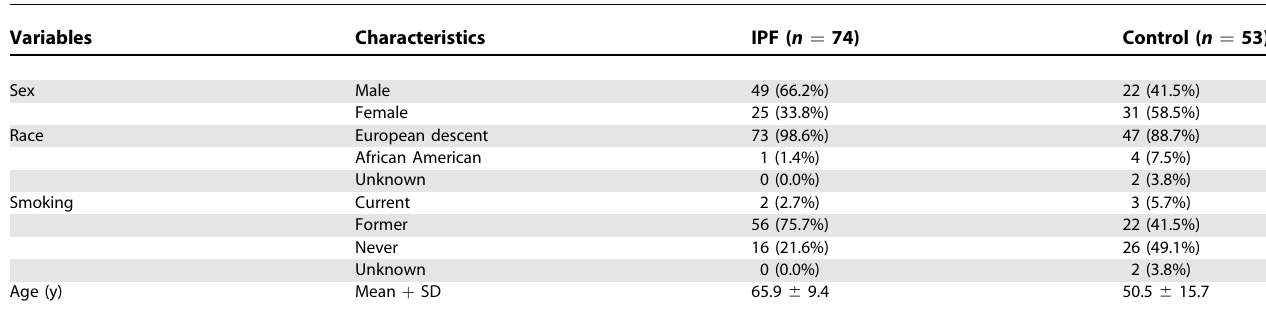
Table 1. Derivation Cohort Patient